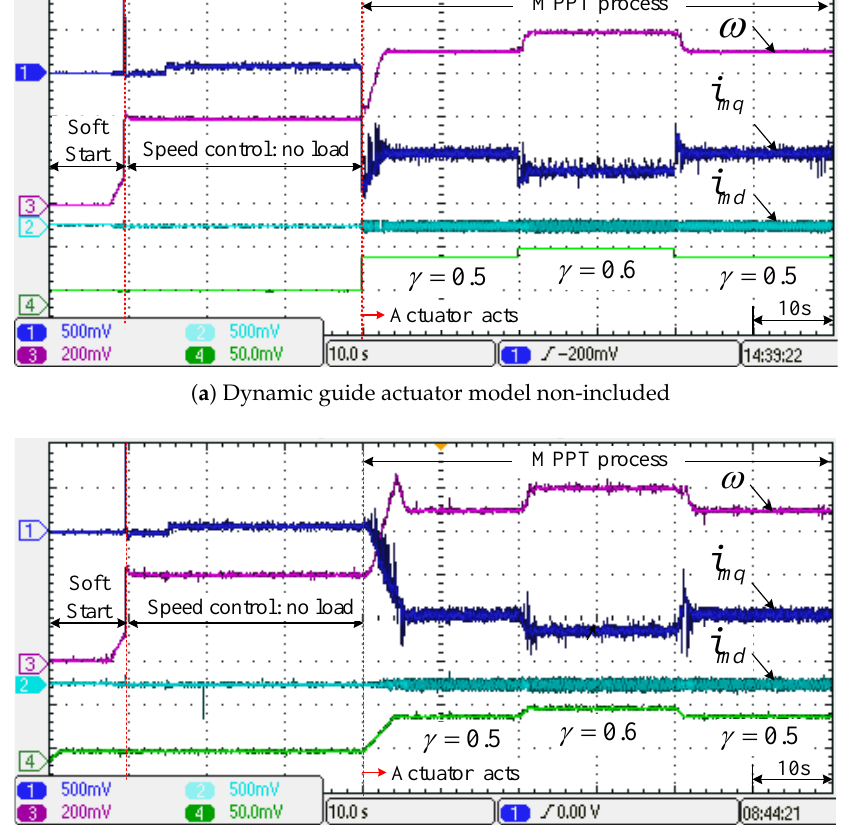
Figure 15. Machine-side control performances with/without introducing guide vane opening dynamic model, the q -axis current i mq (5 A/div), the d -axis current i md (5 A/div), the rotational speed ω (20 rad/s/div).